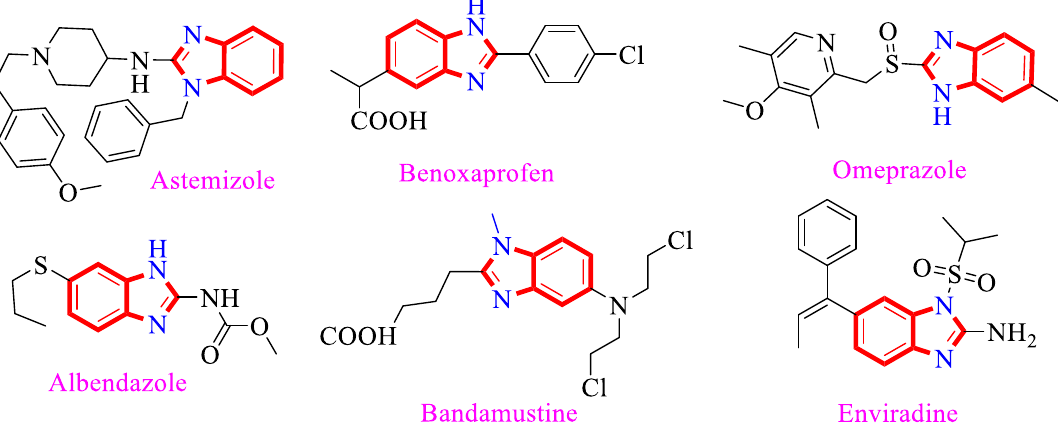
Figure 1. Benzimidazole skeleton containing drugs. The thiazole motif bearing scaffolds displayed a diverse range of biological profile including anti-bacterial, anti-diuretic and anti-Alzheimer's [21]. Additionally, thiazole-